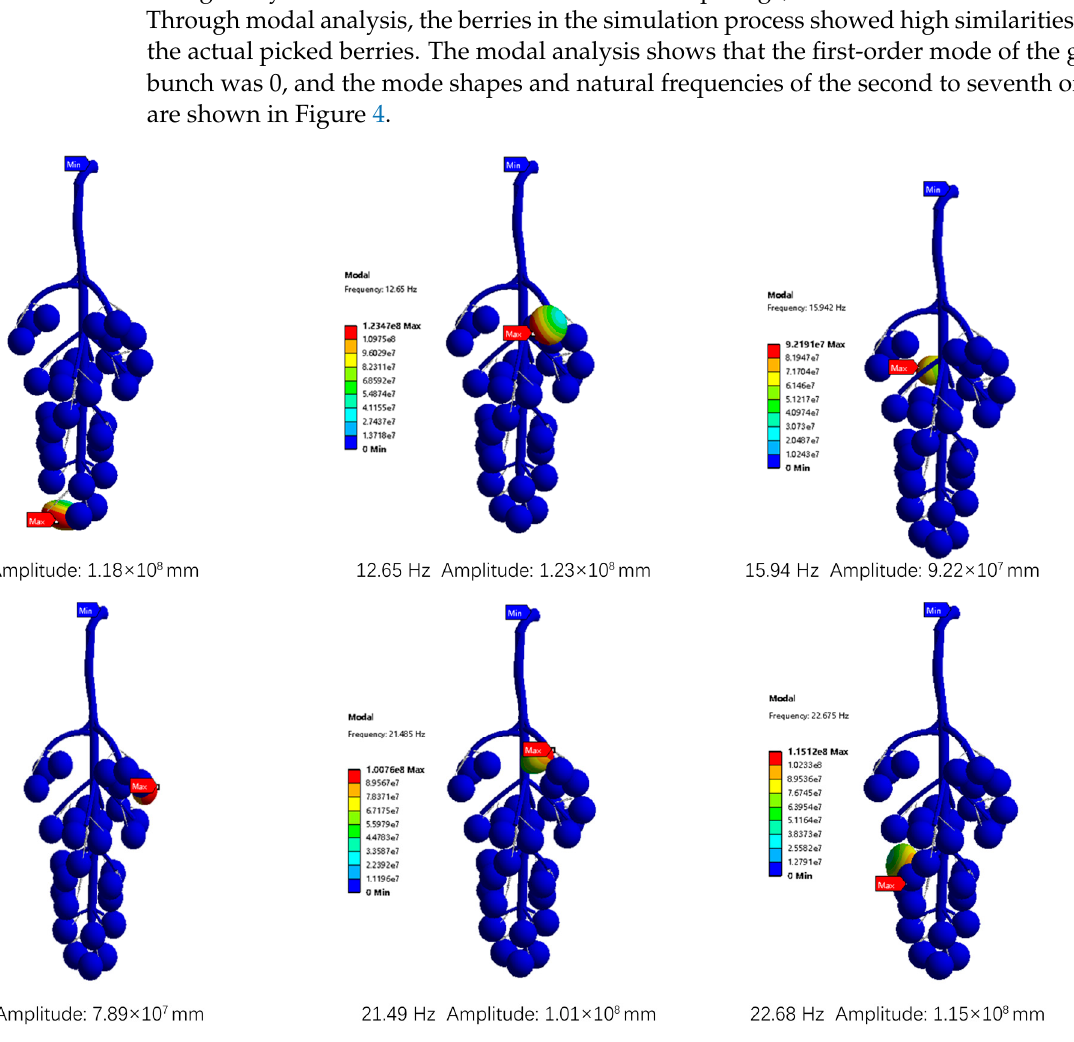
Figure 4. Grape modal analysis and swing shape.